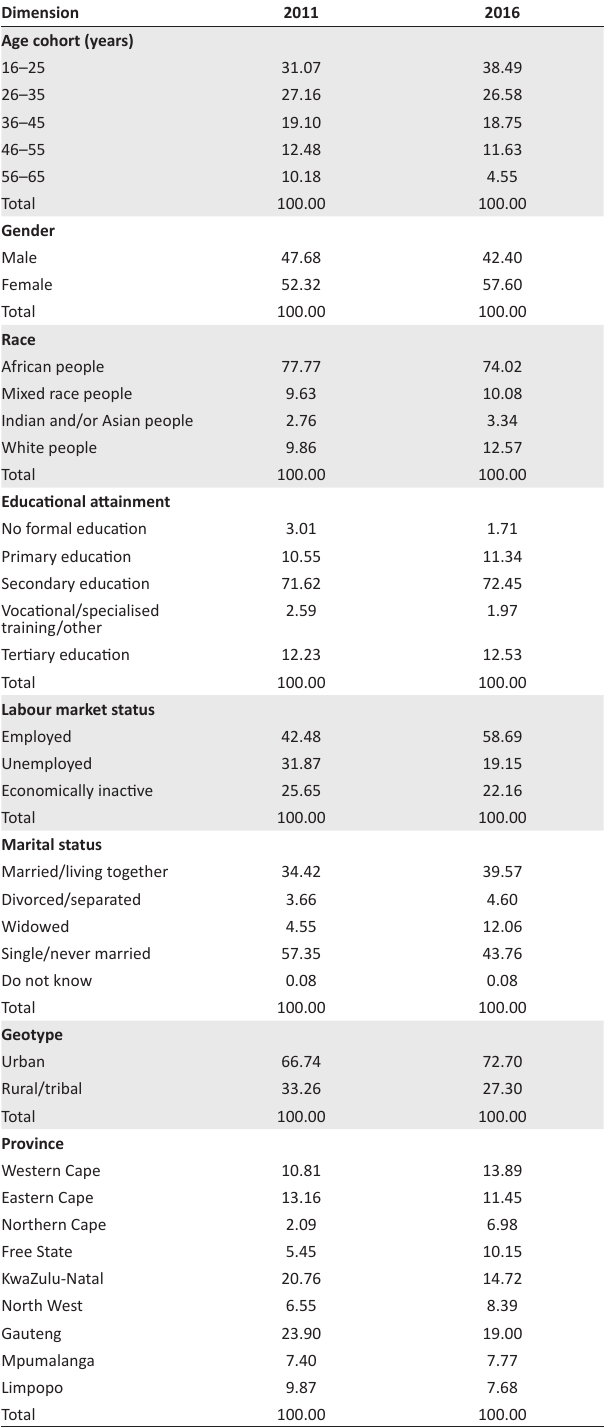
TABLE 1: Demographic statistics of the final sample ( % ).